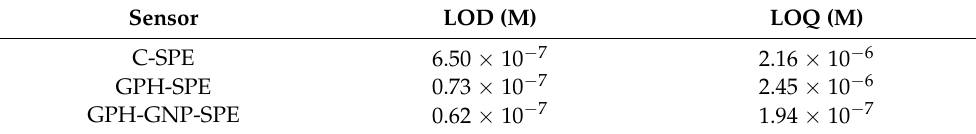
Table 5. LOD and LOQ values for CGA detection for each of the three